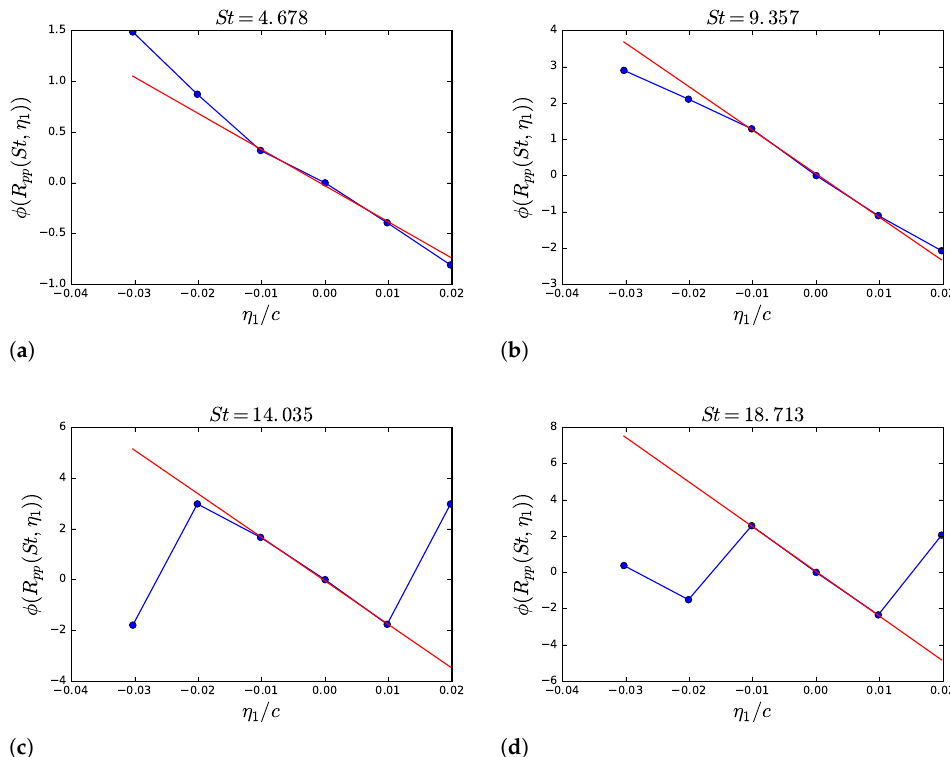
Figure 12. Examples of calculation of the phase of the wall-pressure streamwise correlation coeffi- cient and linear interpolation for the calculation of the wall-pressure fluctuations convective